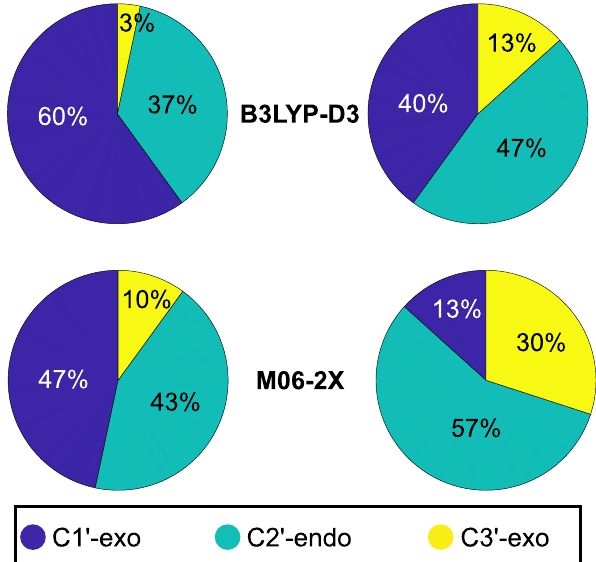
Figure 3. Distribution of the puckering conformations for the single-stranded